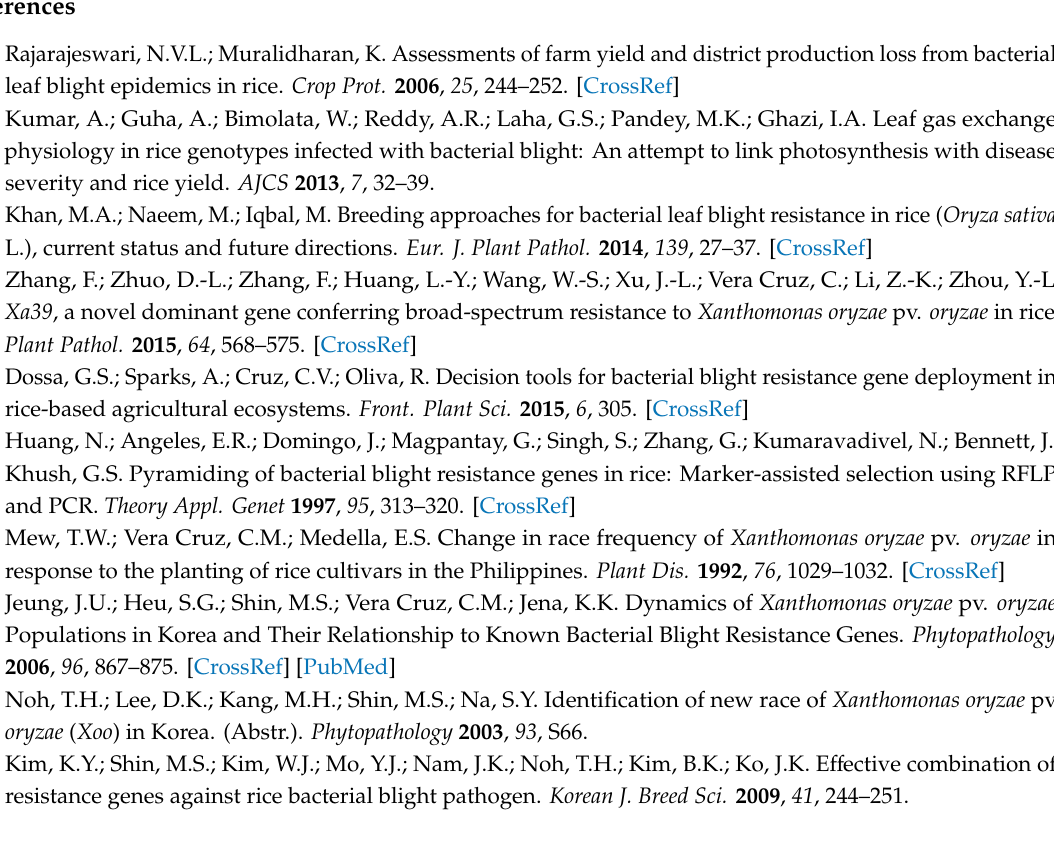
Table S1: qPCR primers used to assay selected K2-induced DEGs identified by microarray, Table S2: Primers designed to clone selected K2-induced DEGs in